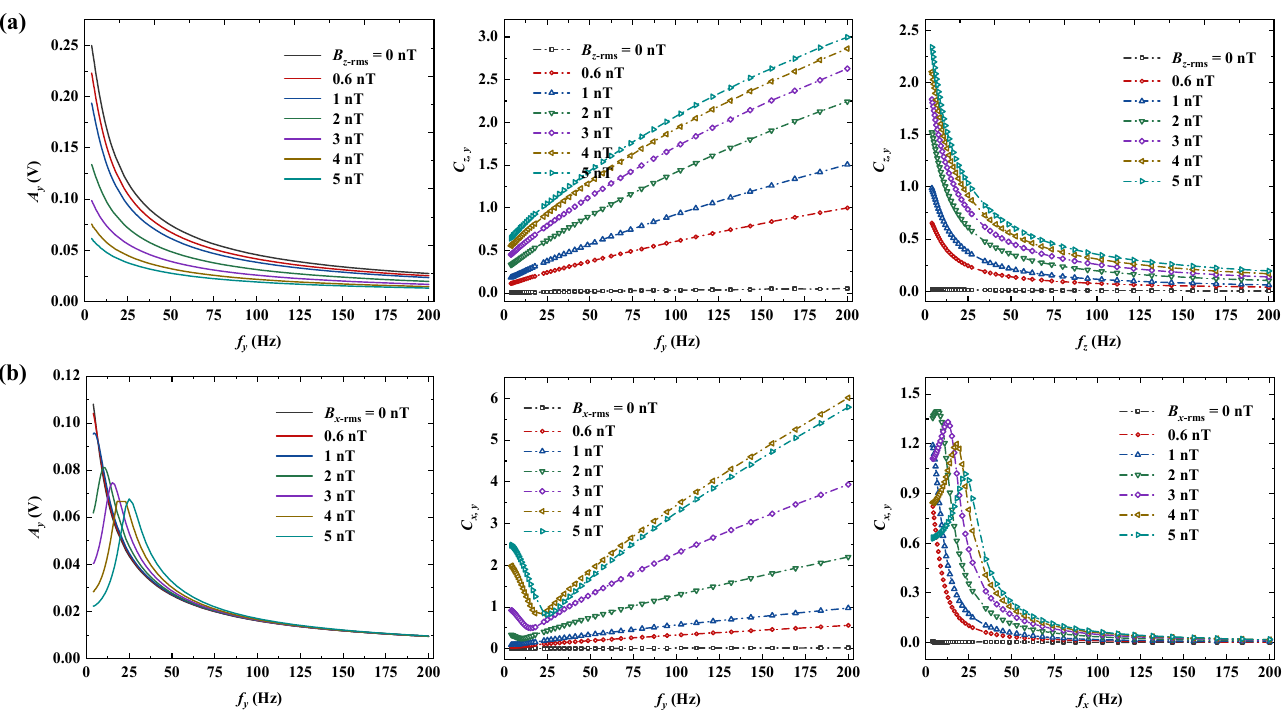
Figure 5. The amplitudes and coupling coefficients dependence on the frequency of the sensitive and interference field under varied interference field amplitude. ( a ) A y and C z , y dependence on f y ; C z , y dependence on f z when B x 0 was applied. ( b ) A y and C x , y dependence on f y ; C x , y dependence on f x when B z 0 was applied.